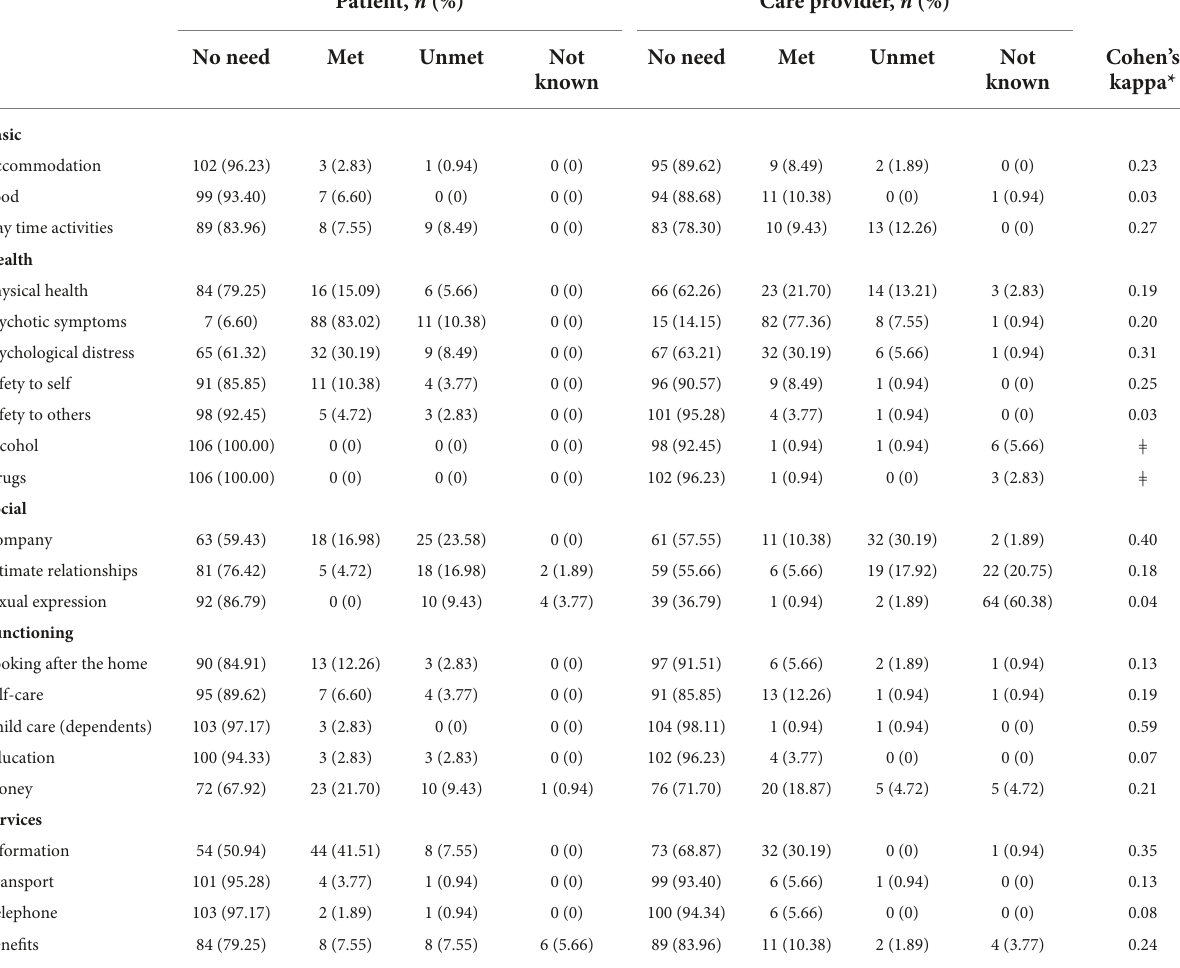
TABLE 2 Needs endorsed by the patients and CPs and their